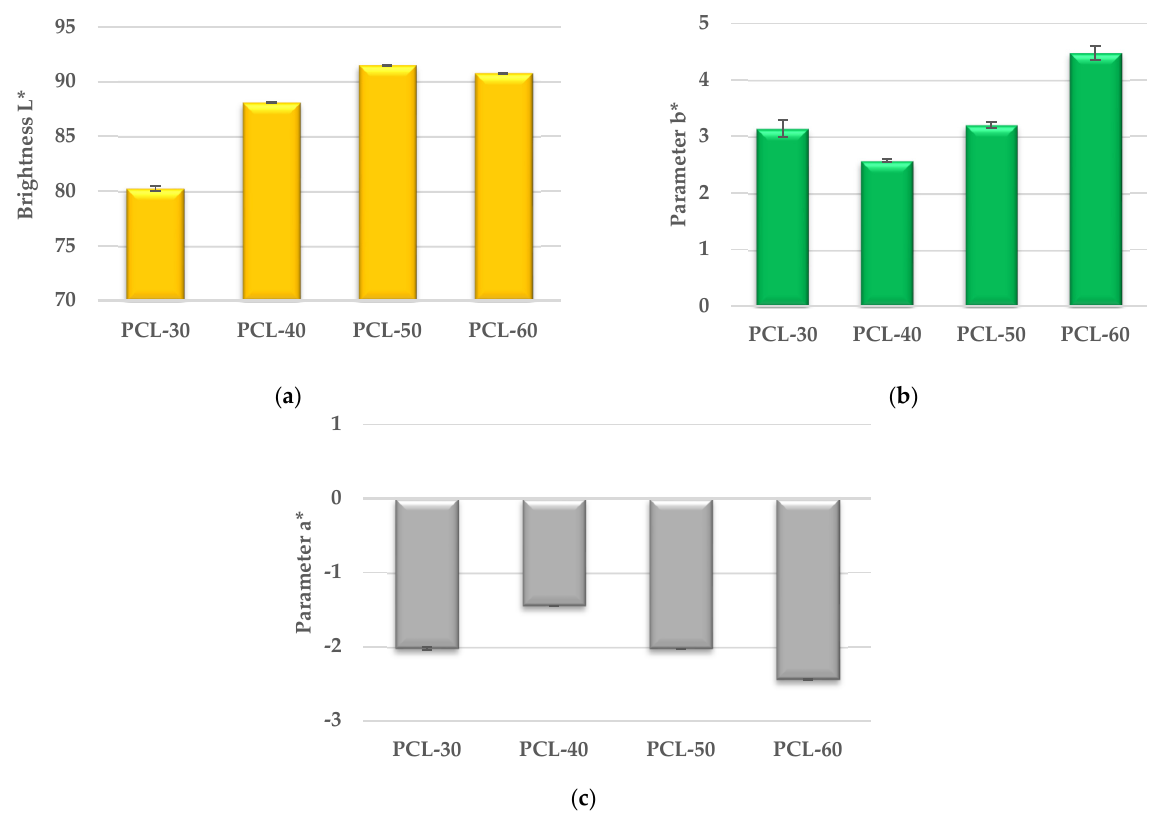
Figure 10. Brightness L* ( a ), Parameter b* ( b ) and Parameter a* ( c ) of synthesized SPTURs.